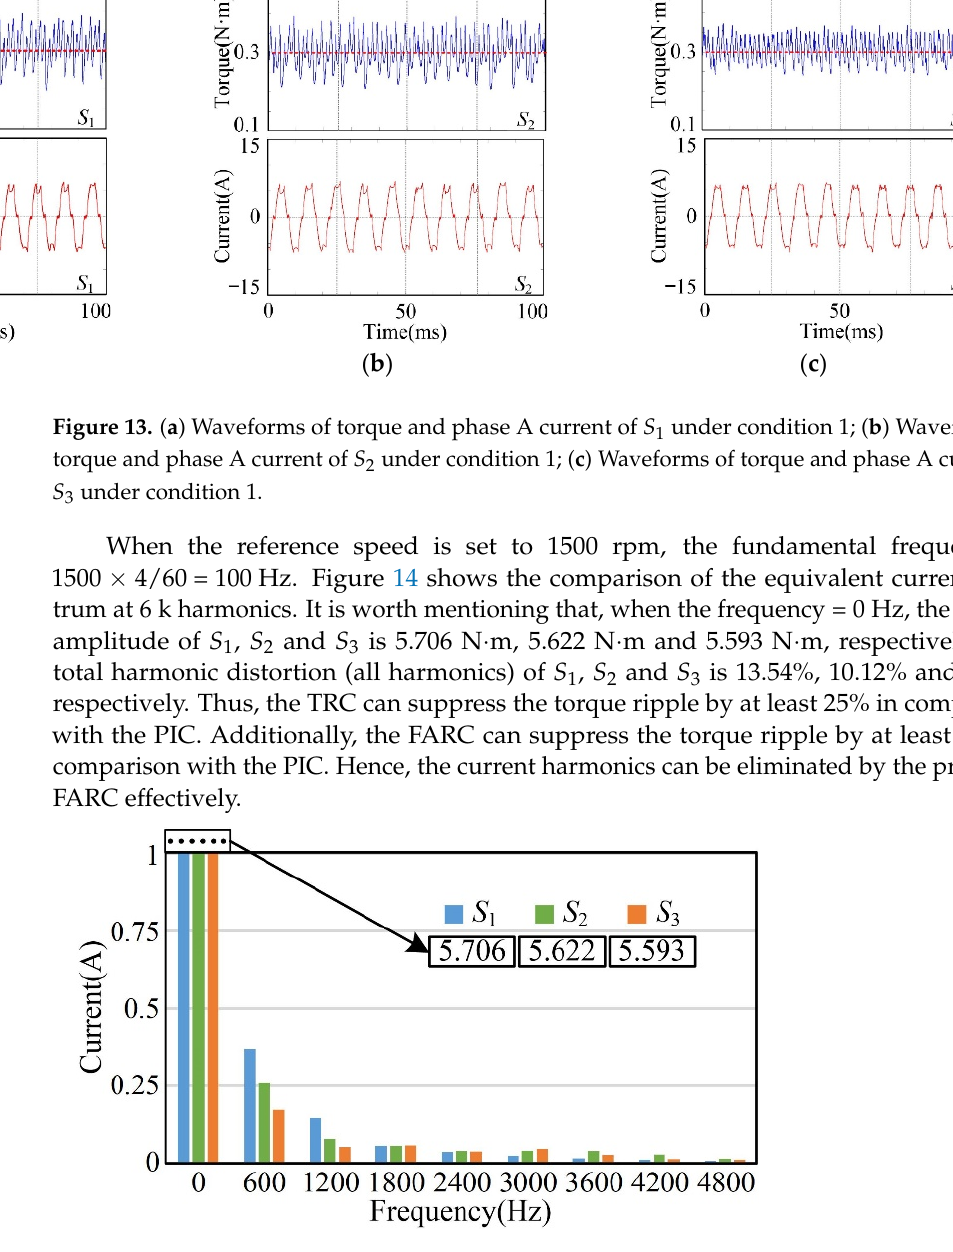
Figure 14. Equivalent current spectrum diagram of S 1 , S 2 and S 3 under condition 1.